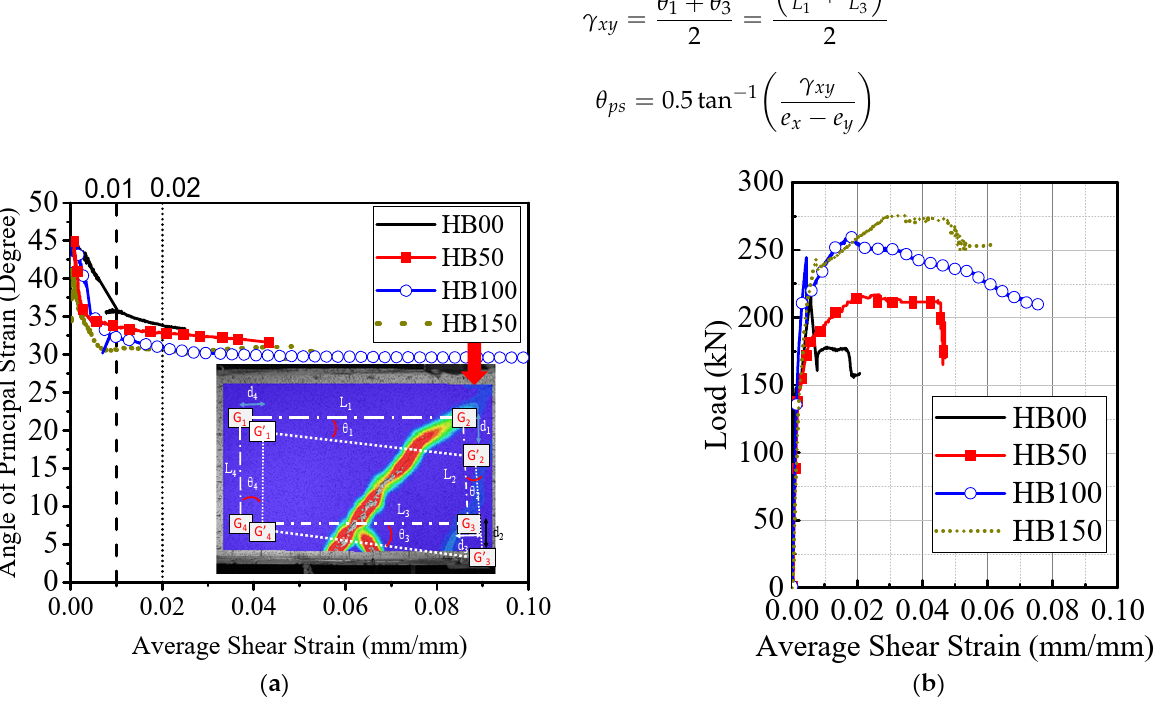
Figure 9. Load versus average shear strains and the angle of the average principal strain of HFRPC beams: ( a ) angle of principal strain vs. average shear strain; ( b ) load vs. average shear strain.